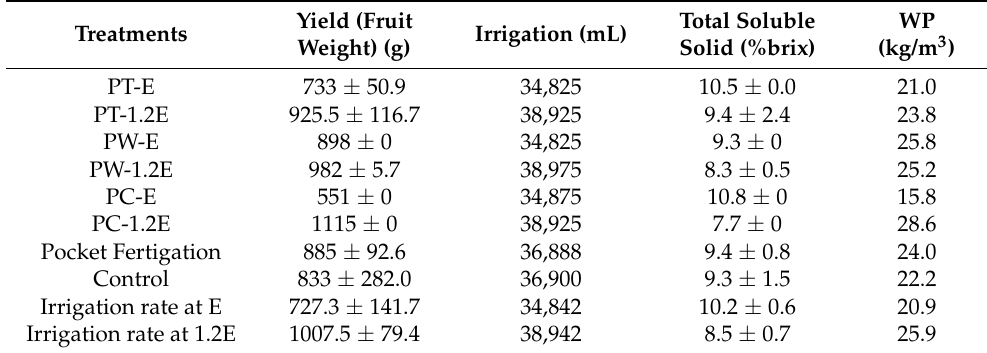
Table 3. Crop and water productivities among the